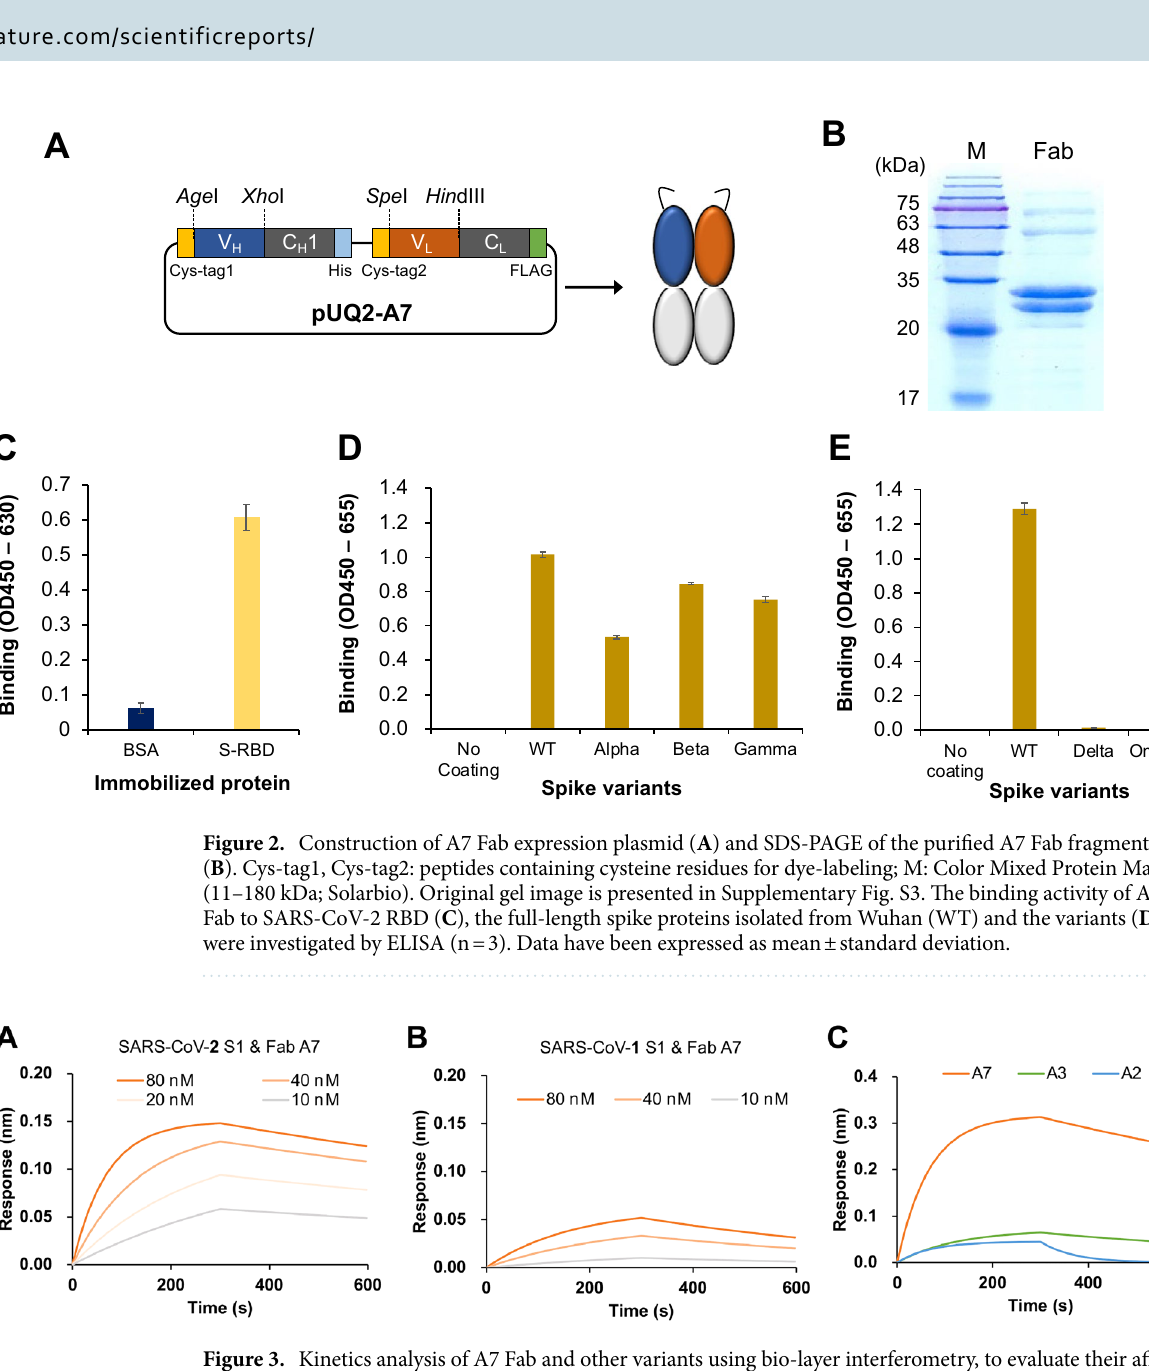
Figure 3. Kinetics analysis of A7 Fab and other variants using bio-layer interferometry, to evaluate their affinity to spike proteins of SARS-CoV-2 and SARS-CoV-1. ( A ) Sensorgram of A7 Fab against SARS-CoV-2 S1 protein. ( B ) Sensorgram of A7 Fab against SARS-CoV-1 S1 protein. ( C ) Sensorgram of different Fab variants against SARS-CoV-2 S1